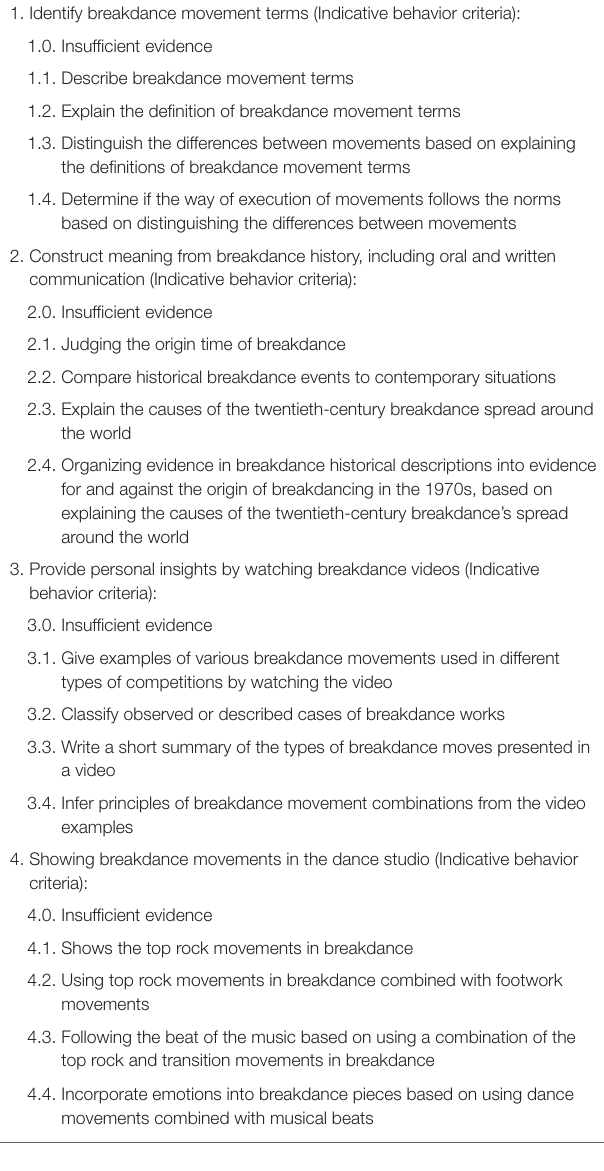
TABLE 1 | Judgment-based assessment